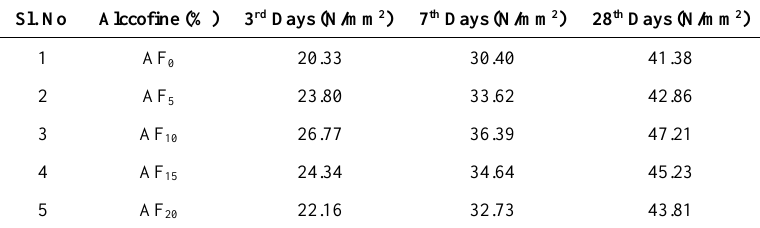
Table 9. Compressive strength test for mortar cubes (OPC AF RS ).